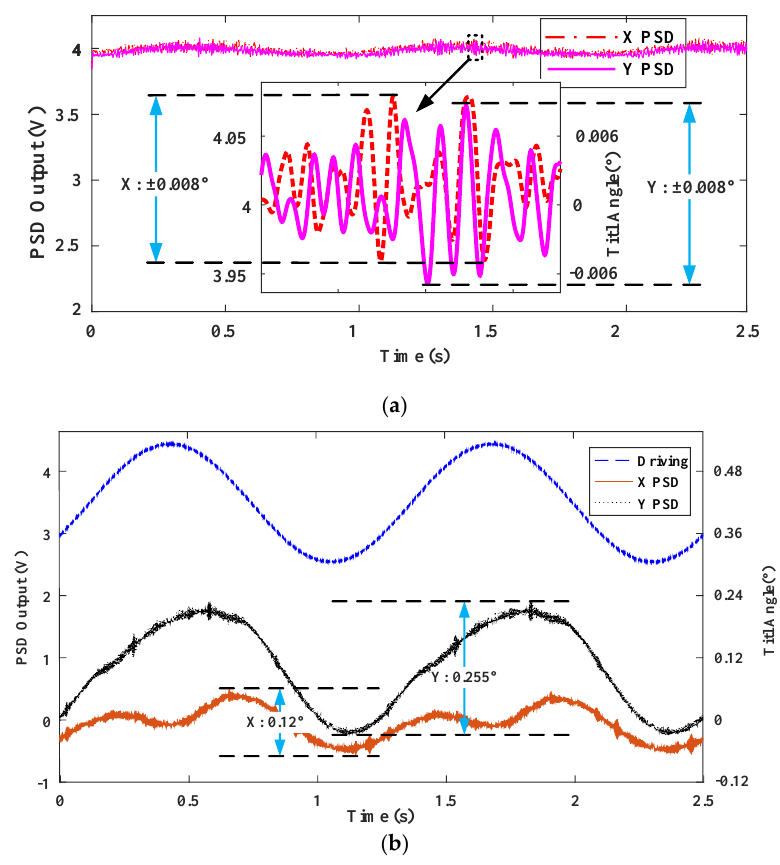
Figure 14. ( a ) Measured tilt angle responses for Look-up Table FTS system using the same driving as PID control. ( b ) Measured tilt angle responses for Look-up Table FTS system using different driving. (3) H∞ robust Control